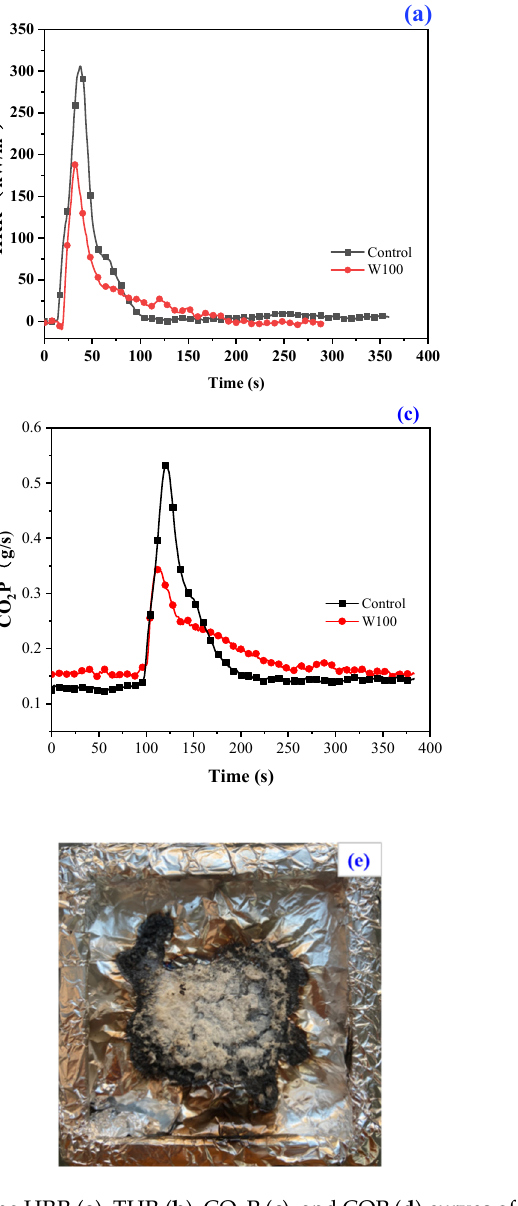
of the control ( e ) and the PBTCA-treated wool ( f ) after the cone calorimetry test. Figure 4. The HRR ( a ), THR ( b ), CO 2 P ( c ), and COP ( d ) curves of the control wool and the wool treated with PBTCA.